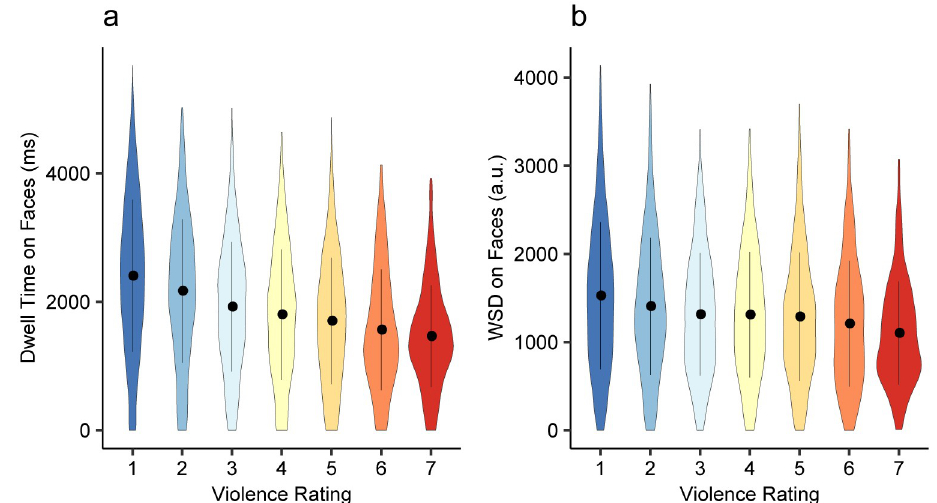
Fig 5. Fixation durations on faces by violence rating. a) AOI dwell time on Face AOIs by violence rating determined by individual participants. b) WSD on Face POIs by violence rating determined by individual participants. Error bars represent ± 1 SD. Note that for the LMM analysis violence ratings were z-scored within participants, but the original ratings were shown here for illustrative purposes. Although the values look similar, WSD and AOI dwell time uses different metrics and cannot be compared directly.